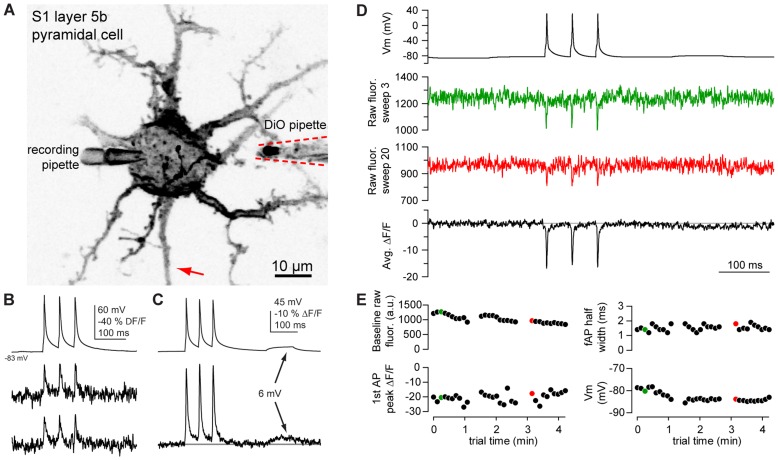
2P excitation of DiO/DPA enables AP detection in a L5 pyramidal cell. A.Negative image of a pyramidal cell membrane labeled with DiO. Dashed lines outline the DiO iontophoretic pipette, withdrawn from the soma after iontophoresis. B. Individual fAPs detected using DiO/DPA in the axon initial segment (arrow in A). The top trace is a somatic whole-cell recording of membrane voltage (Vm), and the middle and bottom traces are successive single trials. Fluorescence traces were not inverted. C. Average of 50 trials showing fAPs and a DiO/DPA optical response to a 6.8 mV depolarization. Data was corrected for photobleaching (<2% decrease ΔF/F over length of trace). D. Vm (top), single trial optical recordings from near the beginning (green) and end (red) of 30 trials, and an average of all 30 trials (bottom trace) from another pyramidal cell. Images were made on soma membrane. No photobleaching correction was necessary in this cell. E. Summary of baseline fluorescence, half width and peak ΔF/F of 1st fAP in the train, and baseline Vm, captured in 3 sets of 10 trails. Colored data points correspond to values measured from individual sweeps in D. Note that values were calculated from unfiltered data.